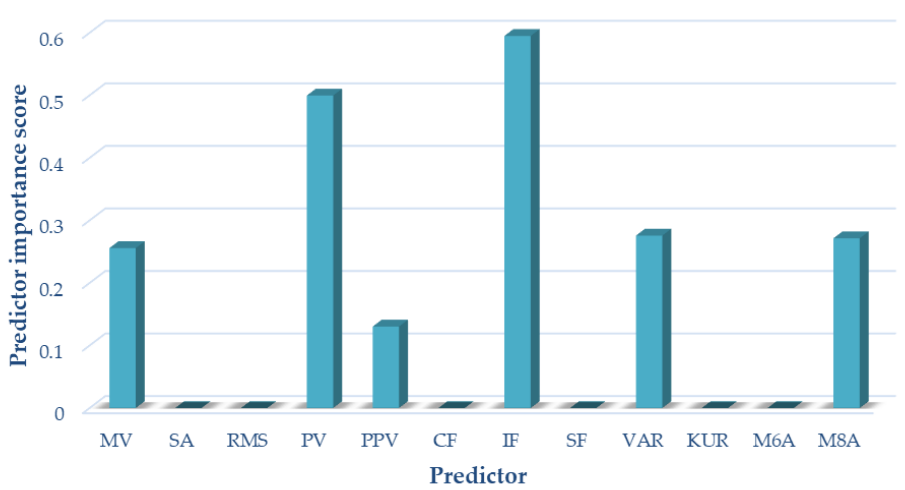
Figure 7. Selection of optimal features for variant II (CKC).